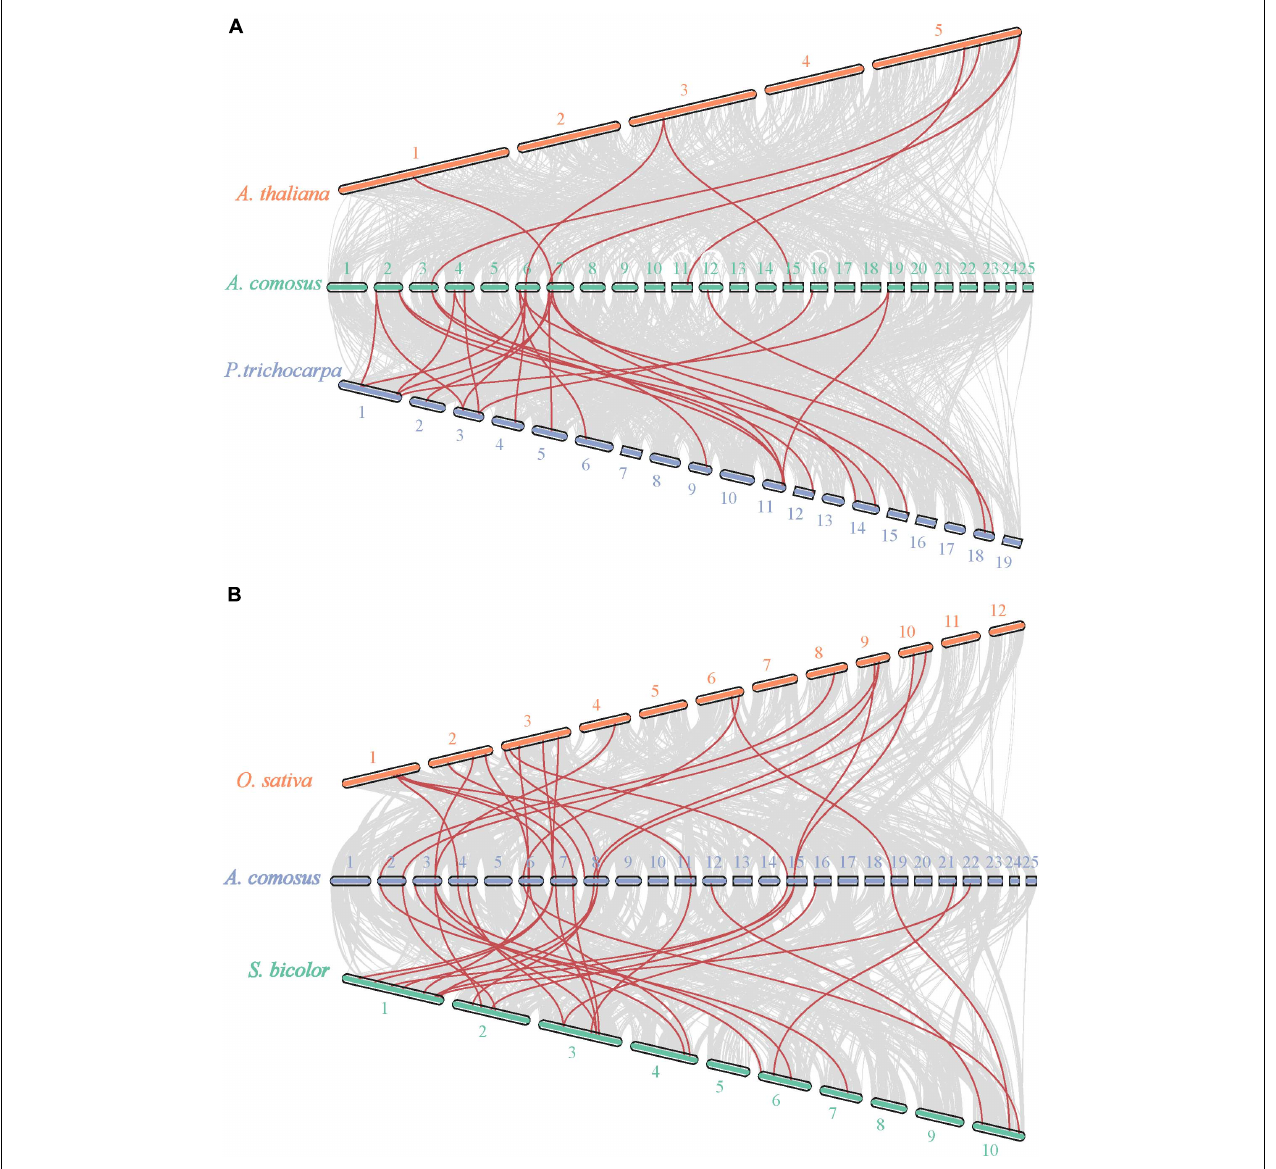
FIGURE 4 | Synteny analysis of SBT genes between pineapple and Arabidopsis, populus, rice, and Sorghum. (A) Synteny analysis of SBT genes between pineapple and two dicotyledonous plants, Arabidopsis and populus. (B) Synteny analysis of SBT genes between pineapple and two monocotyledonous plants, rice and Sorghum. Gray lines in the background indicate the collinear blocks within pineapple and other plant genomes, while the red lines highlight the syntenic SBT gene